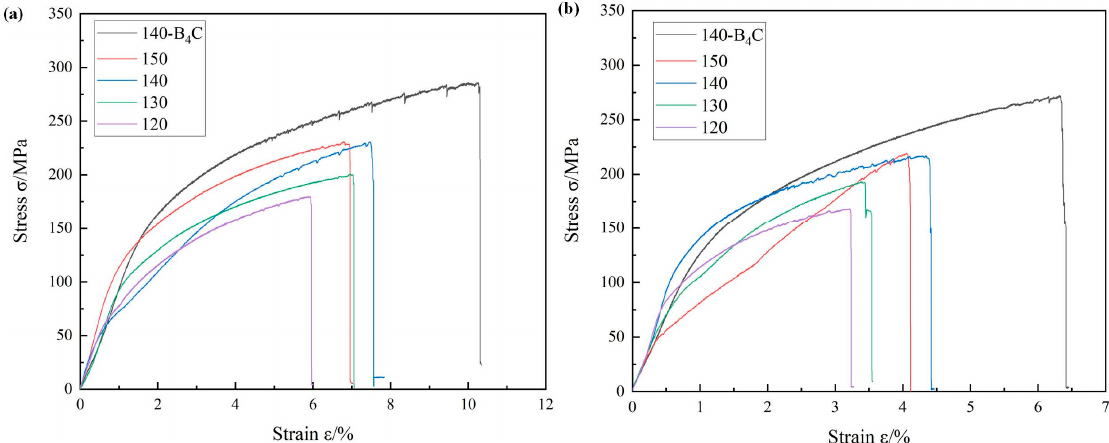
Figure 10. Stress–strain curves for aluminum alloys in the deposited state ( a ) transverse direction, ( b ) longitudinal direction.